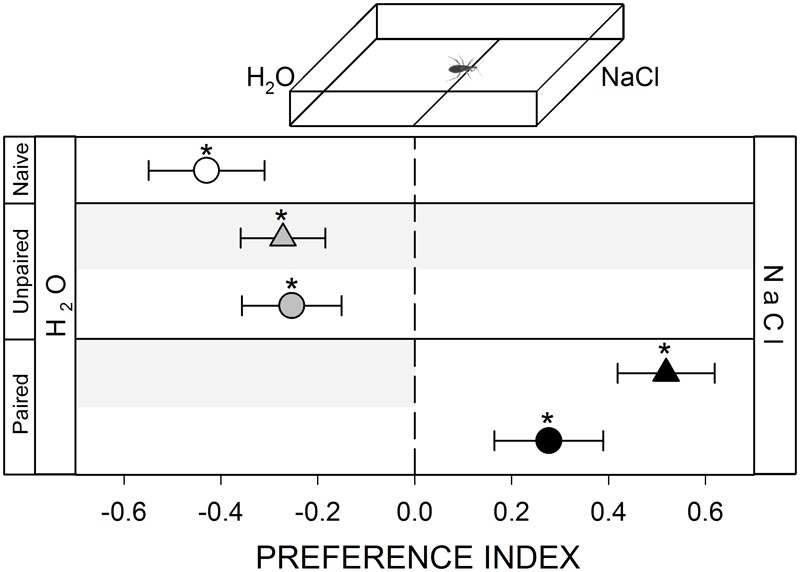
Responses of R. prolixus to a gustatory stimulus. Insects were innately repelled by NaCl (white circle, p < 0.05). Yoke controls presented the same pattern (gray triangle and circle, p < 0.05 in both cases). During training, insects avoided the punished zone: i.e., the H2O side (black triangle, p < 0.05). During test NaCl side was still preferred (black circle, p < 0.05) evincing an experience-dependent behavioral plasticity. Each point represents the mean (±SE) spatial preference of 30 insects individually released in a 2-choice rectangular walking arena. Asterisks denote statistical differences between the PI and the value 0 (p < 0.05) evinced by One sample T-test. Gray shadows show the zone in which punishment was delivered during unpaired and paired trainings.